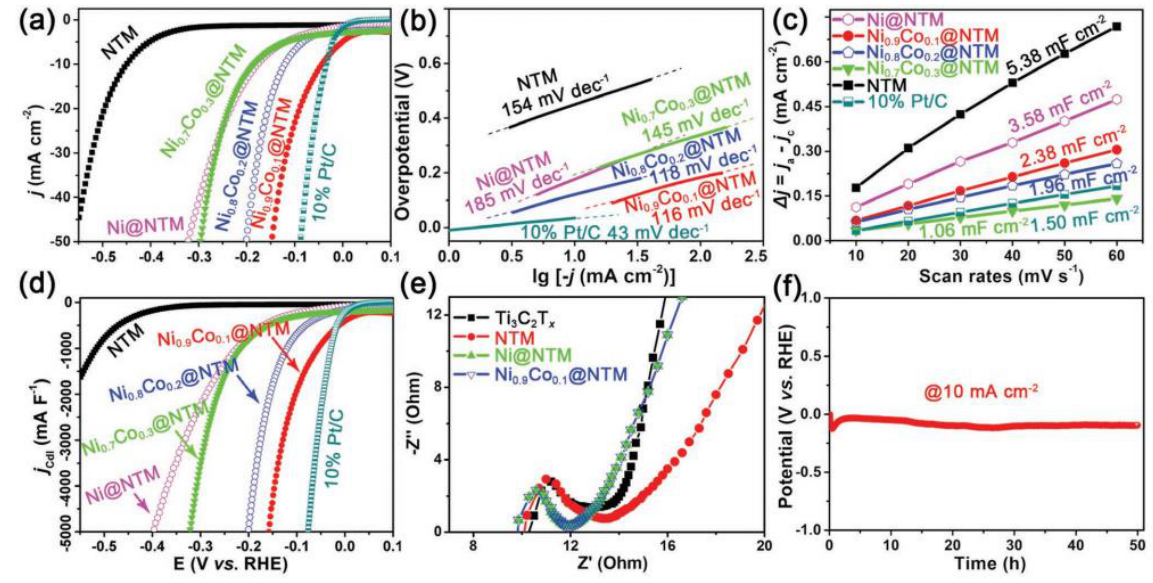
Figure 6. ( a ) HER polarization curves of the series NiCo@NTM nanohybrids, Ni@NTM nanohybrid, NTM and 10% Pt/C in 1M KOH with a scan rate of 5 mV/s. ( b ) Corresponding Tafel plots of the series samples. ( c ) The charging current density differences plotted against scan rates of the as-prepared series NiCo@NTM and Ni@NTM nanohybrids. The linear slope is equivalent to twice the electrochemical double-layer capacitance (Cdl). ( d ) HER polarization curves shown in ( a ) normalized by the Cdl. ( e ) Nyquist plots of the electrodes modified by Ti 3 C 2 T x , NTM, Ni@NTM, and Ni 0.9 Co 0.1 @ NTM measured at zero overpotential versus RHE. ( f ) The chronopotentiometric curves of the Ni 0.9 Co 0.1 @NTM nanohybrid under static current density (10 mA/cm 2 ) over 50 h. Adapted from [180].